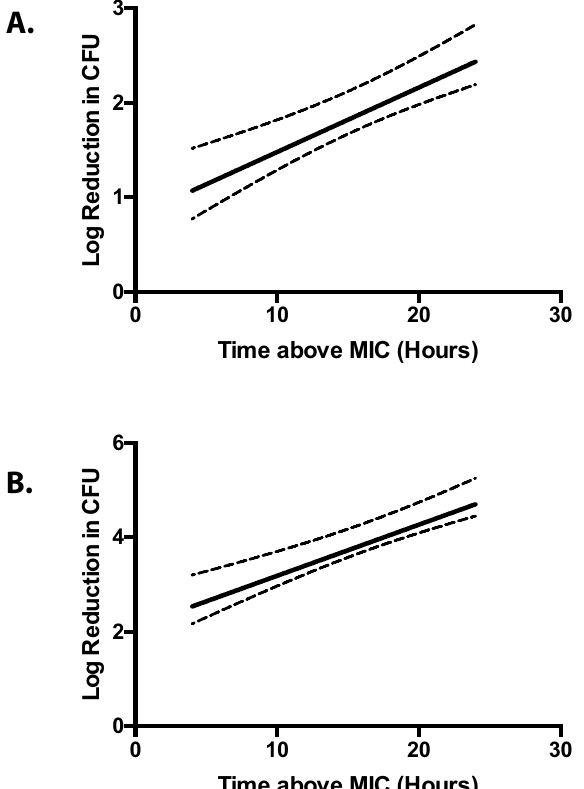
Figure 3. Log-reduction in CFU vs. Time > MIC exhibits a linear relationship for E. coli and K. pneumoniae BLS in the OS cockroach model. Data presented in Figs. 1 and 2 were used to extrapolate CFU reduction